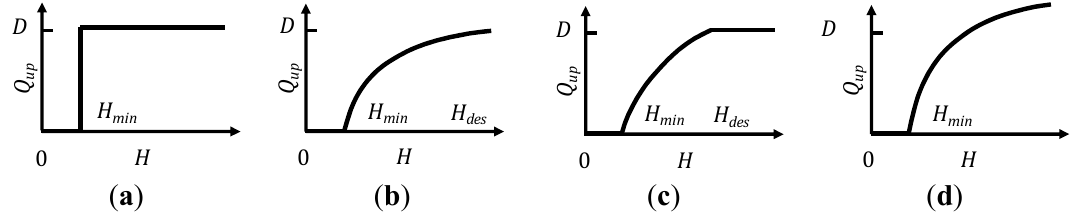
Figure 3. Head-driven analysis methods: ( a ) Bhave [14]; ( b ) Germanopoulos [15]; ( c ) Wagner et al. [16]; and ( d ) Reddy and Elango [17]. (cid:1830) = required outflow at